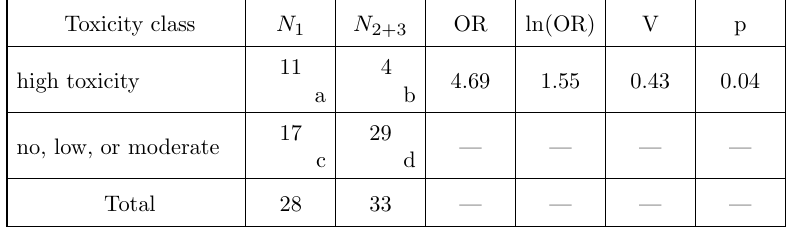
Table 5. Odds ratios (OR) for the second partial criterion under study